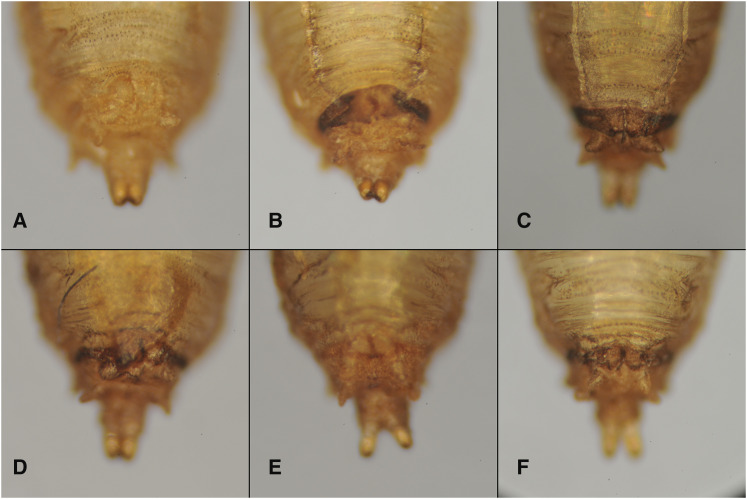
The pupal case of speck mutants display excess pigmentation at the anal pad. All images are of the posterior ventral sides of pupal cases following eclosion. A.) An Oregon R pupal case shows normal posterior pigmentation. B.) A speck1 mutant (cn1
bw1 speck1) shows the anal pad region is darkly pigmented. C.) A speck2 mutant (speck2bs2) shows a similar dark band as speck1 and the pupal case overall is slightly darker. D.) An insertion in AANAT1 (AANAT1MB02738) shows a similar phenotype and can be reverted to wild type upon mobilization (E). F.) Knockdown of AANAT1 via RNAi can reproduce the phenotype (Tubulin-GAL4, UAS-Dicer2; UAS-AANAT1HMS01617).